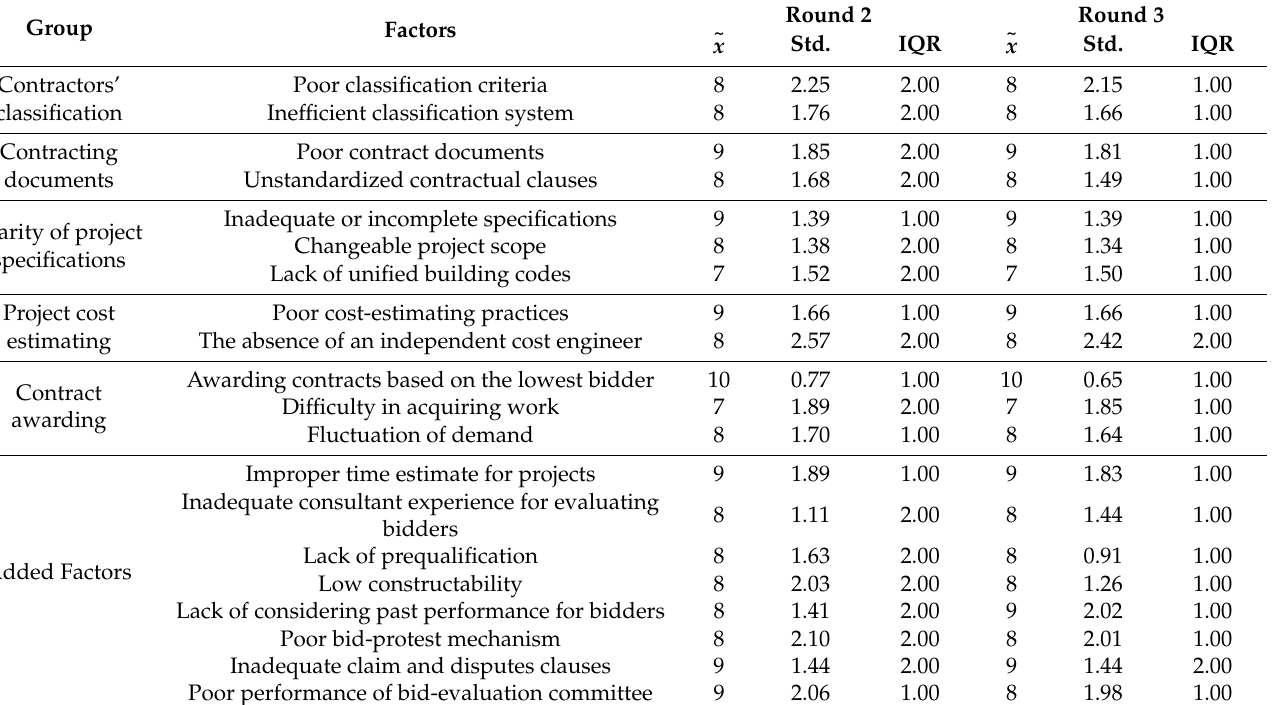
Table 2. Summary of the panel evaluation of influencing degree of the challenging factors in both round two and round